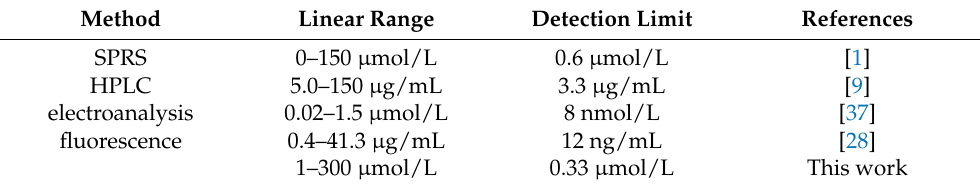
Figure 5. ( A ) Fluorescence intensity curves of MTX with different concentrations; ( B ) linear relation curve of log (F 0 /F) and concentration of MTX. Table 1. Comparison of major characteristics for MTX with other published methods.